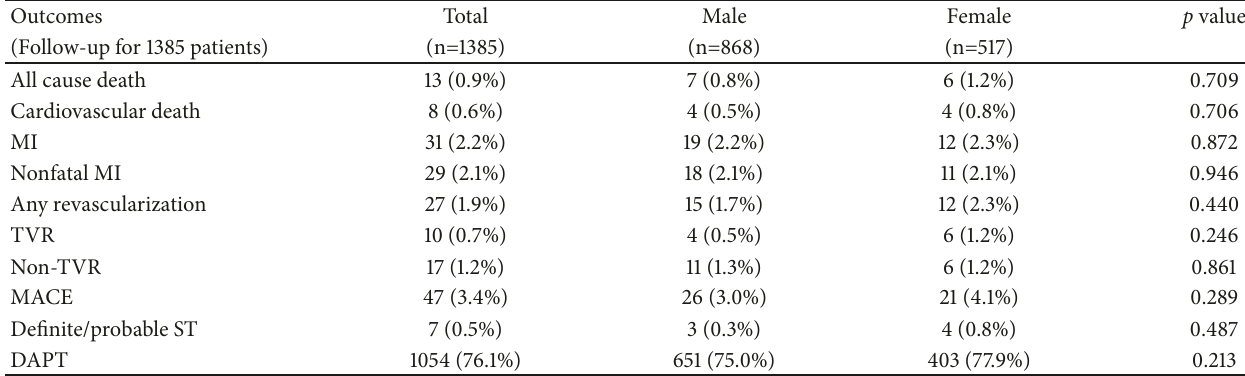
Table 3: Clinical outcomes comparing male and female for 12